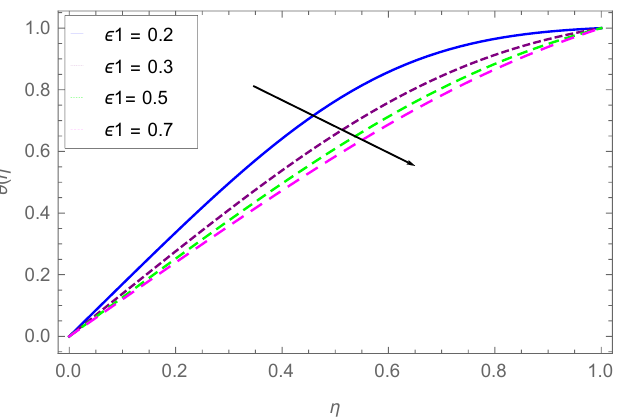
Figure 9. Graph displaying θ ( η ) dependence on (cid:101) 1 . The dependence of the fluid temperature θ ( η ) on η for increasing values of (cid:101) 2 is shown in Figure 10. An increasing trend in the temperature is observed at the intermediate values of η for increasing (cid:101) 2 . Thus, the changing dynamic nanofluid viscosity, which is associated with increasing (cid:101) 2 , results in an increase in the temperature distribution of the nanofluid.